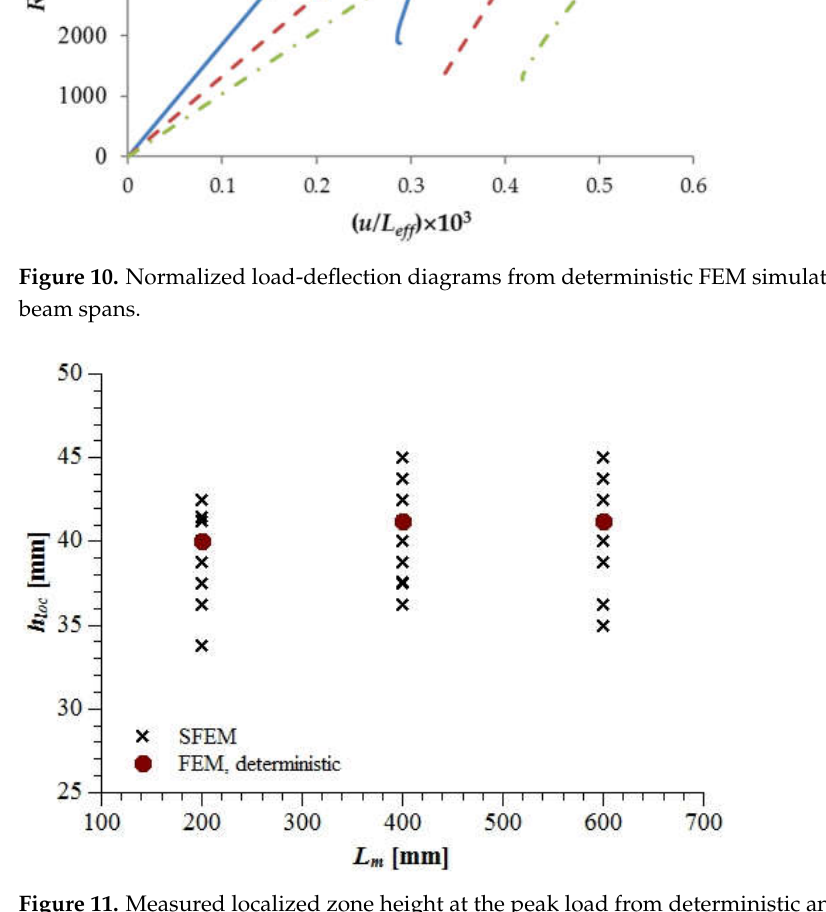
Figure 11. Measured localized zone height at the peak load from deterministic and stochastic FEM simulations with cov = 0.16.